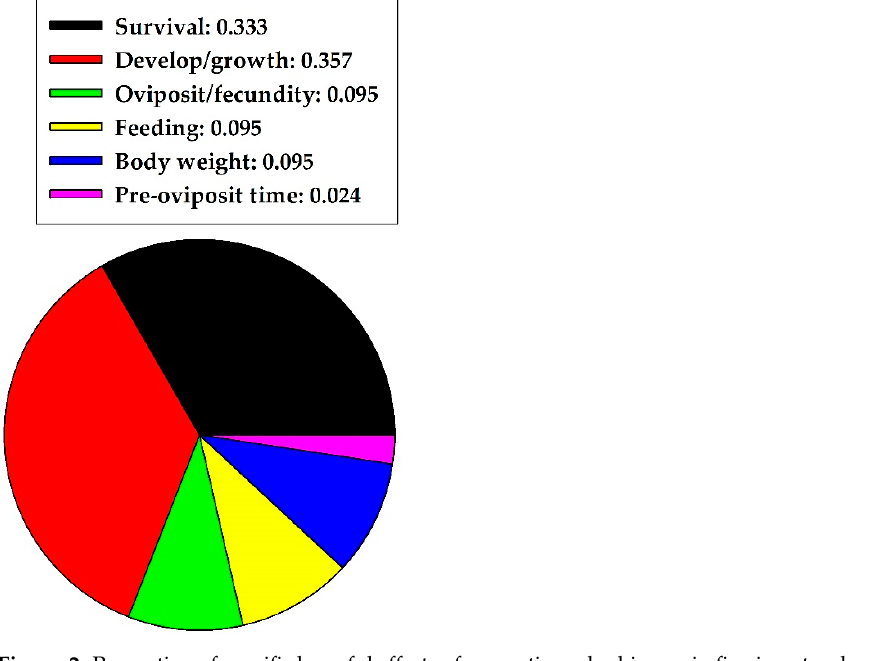
Figure 2. Proportion of specific harmful effects of quercetin on herbivores in five insect orders combined.